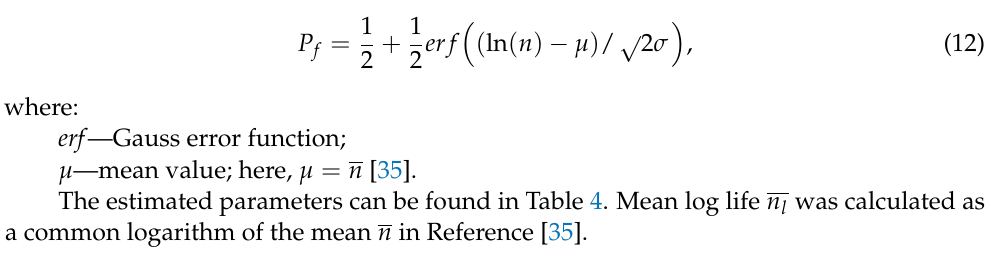
Table 4. Parameters of log-normal distribution for fatigue lives of 2524-T3 aluminium alloy. Stress Amplitude σ a ,